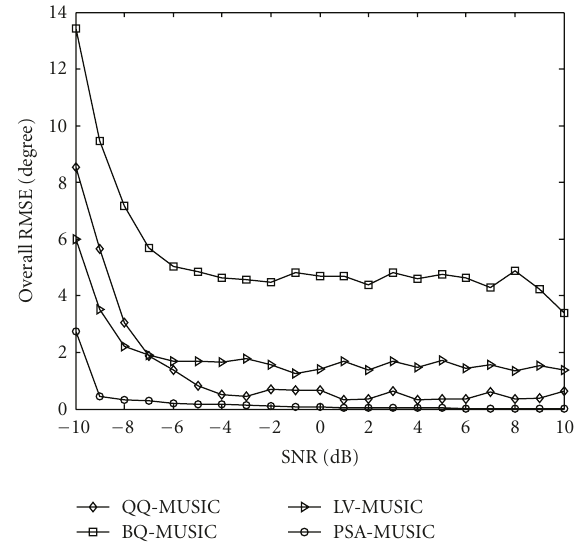
Figure 7: RMS estimation errors versus SNR for an ideal EM vector-sensor array.